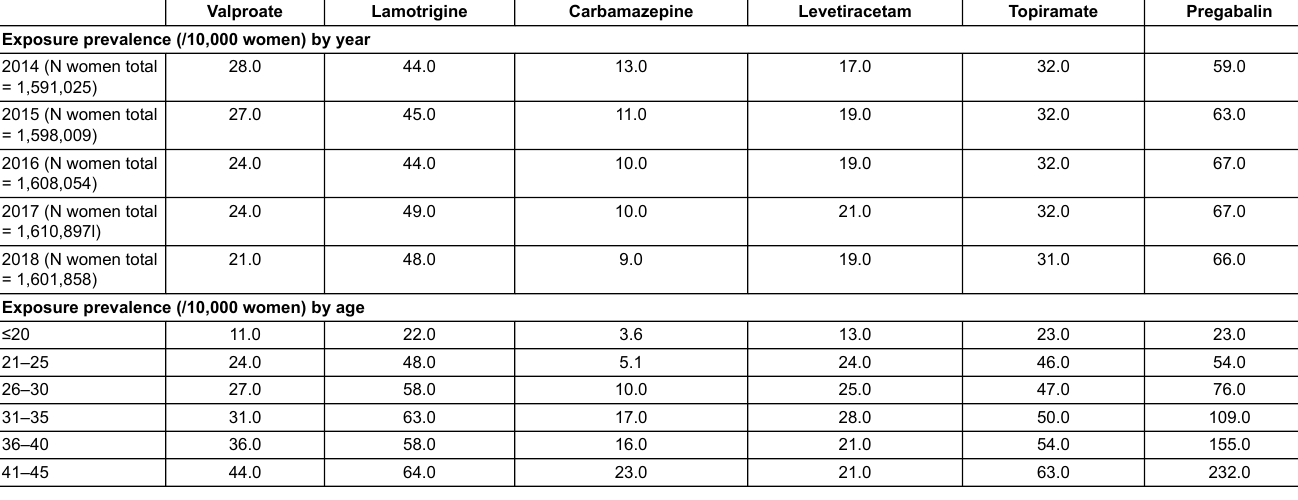
Table 3: Weighted prevalence of exposure to antiseizure drugs (per 10,000) in women of childbearing age (2014–18). Valproate Lamotrigine Carbamazepine Levetiracetam Topiramate